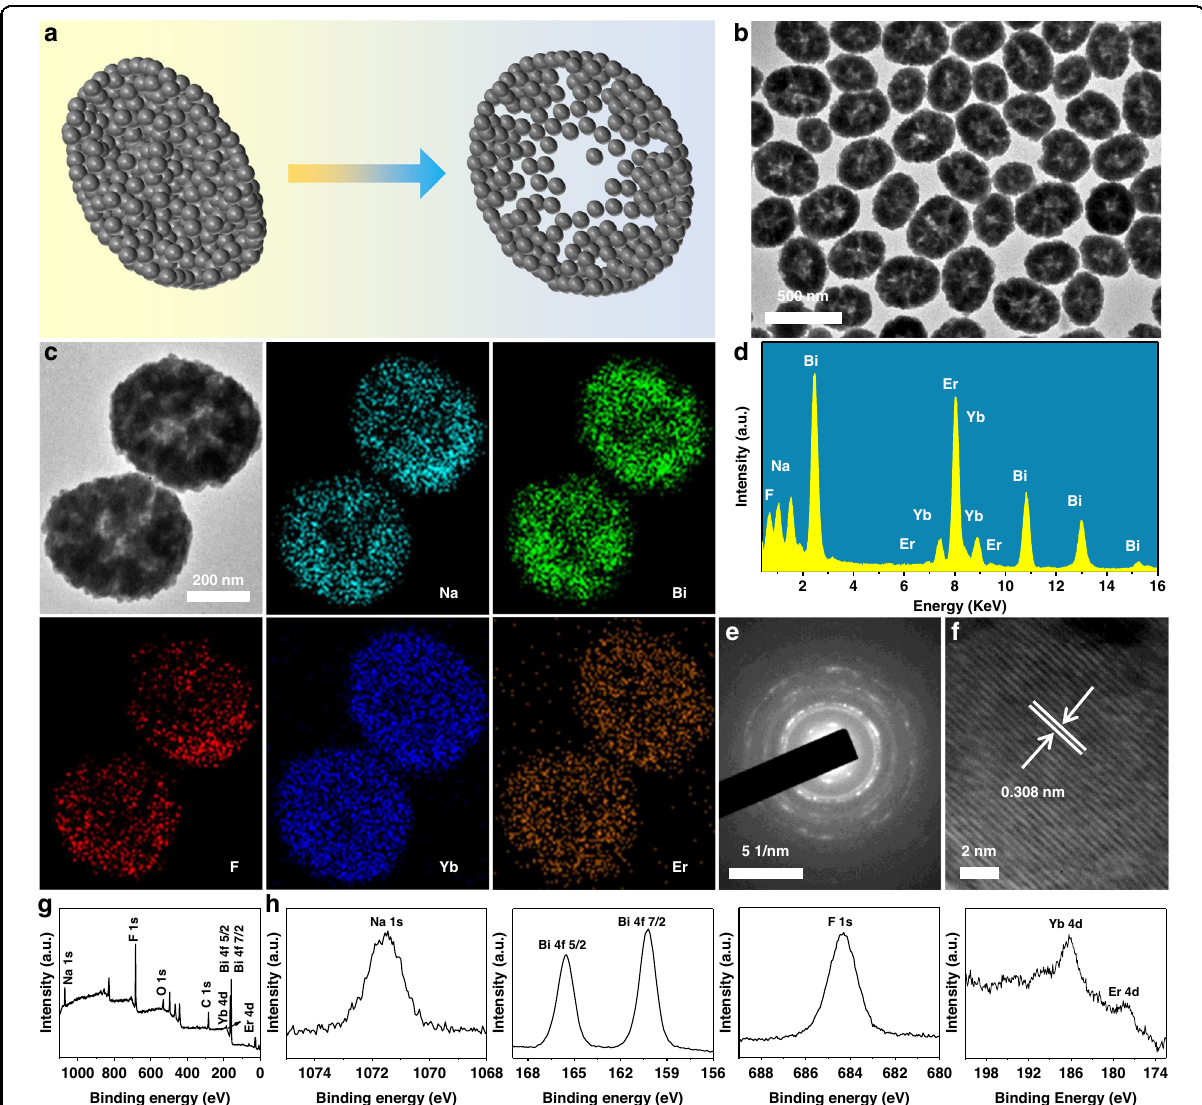
Fig. 1 Structural characterization of NBFYE HNPs synthesized by adding 1.5 g PAA and 5 mL H 2 O to the reaction system. a Schematic diagram of the structural change from solid to hollow. b TEM image. c Elemental mapping images. d EDS spectra. e SAED pattern. f HRTEM image. XPS spectra: ( g ) survey spectrum, and ( h ) high-resolution spectra of Na 1s, Bi 4f, F 1s, Yb 4d, and Er